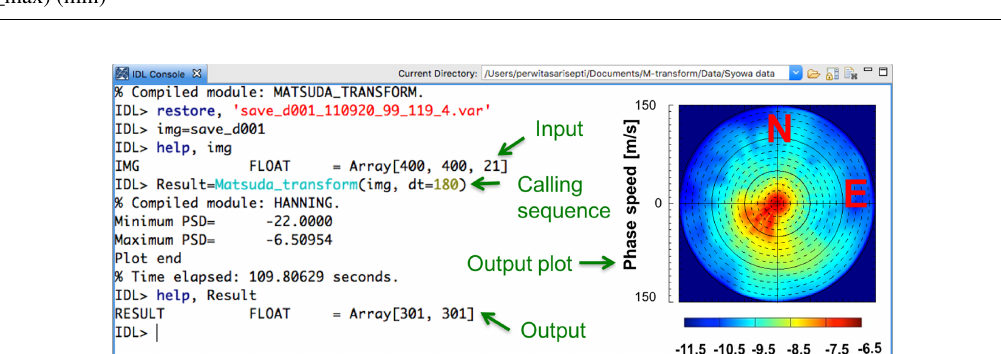
Figure 2. Example of how to use the Matsuda-transform (M-transform) program, showing the input, calling sequence, total calculation time, and output as 2-D phase velocity